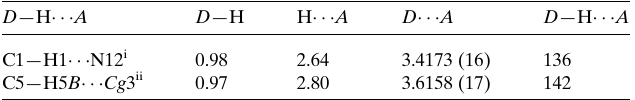
Table 1 Hydrogen-bond geometry (A˚ , (cid:2) ). Cg is the centroid of the cyclohexa-1,3-diene ring.